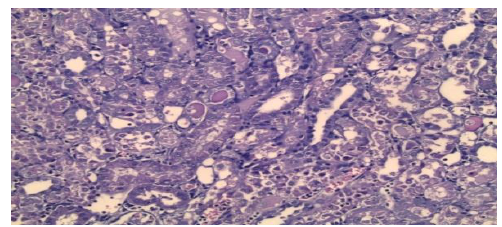
Figure (4) : Saline treated rats. Day 5: rat n: 7(loss of brush border, sloughing, Focal vacuolization and epithelial